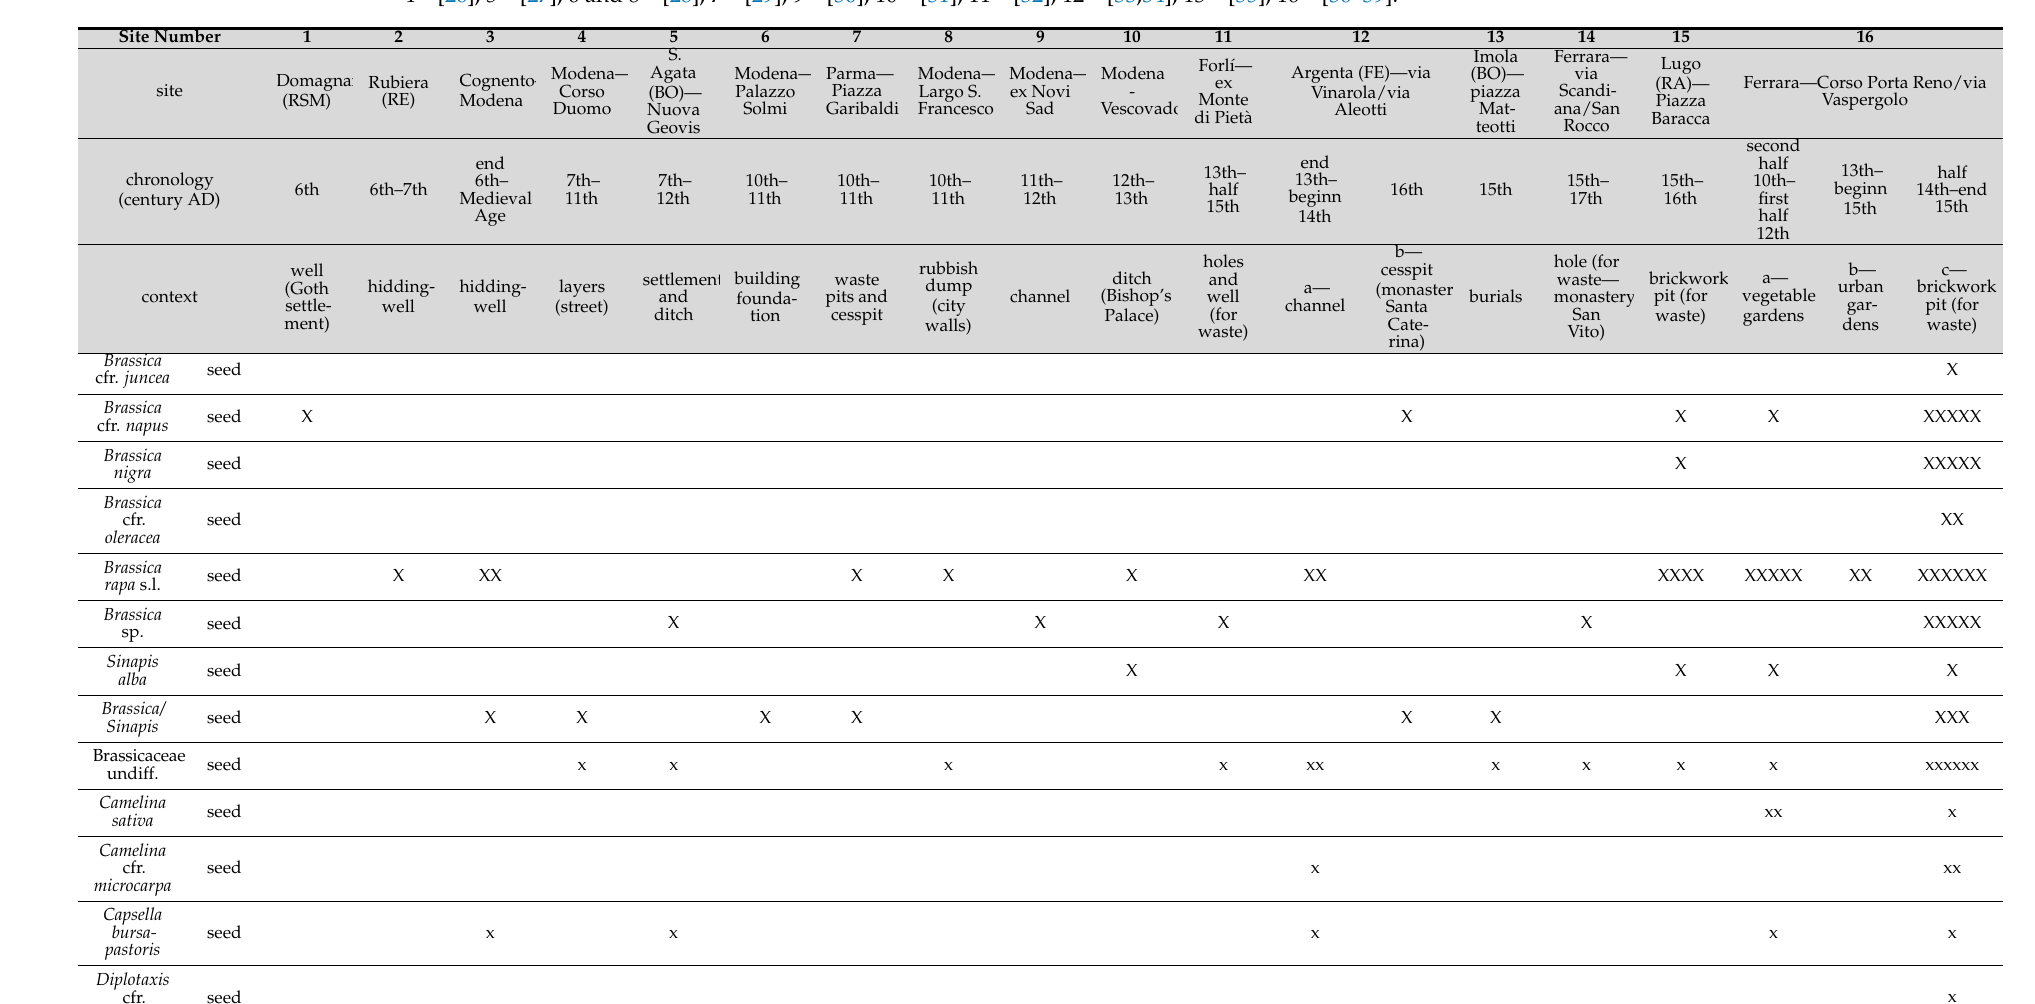
Table 1. Brassicaceae records in Emilia-Romagna sites (6th—15th century AD). Site references for archaeobotanical analysis: 1—[23]; 2, 14, and 15—[22,24];